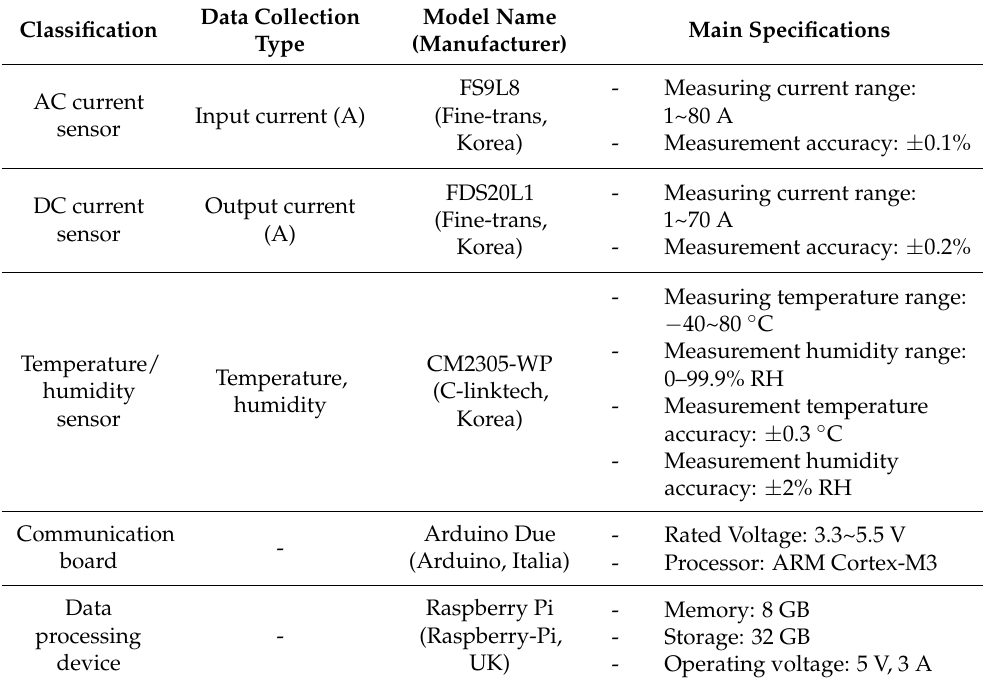
Table 2. Detailed specification of fast-charger power module failure-prediction and management system.